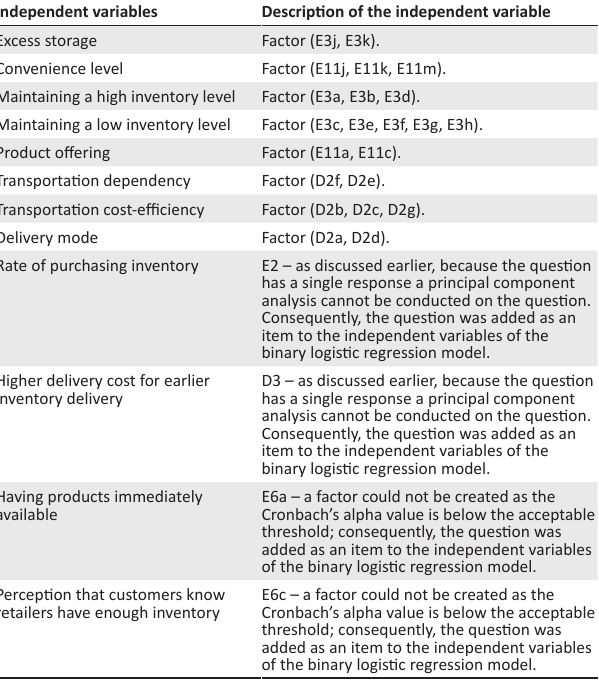
TABLE 4: Summary of the 12 independent